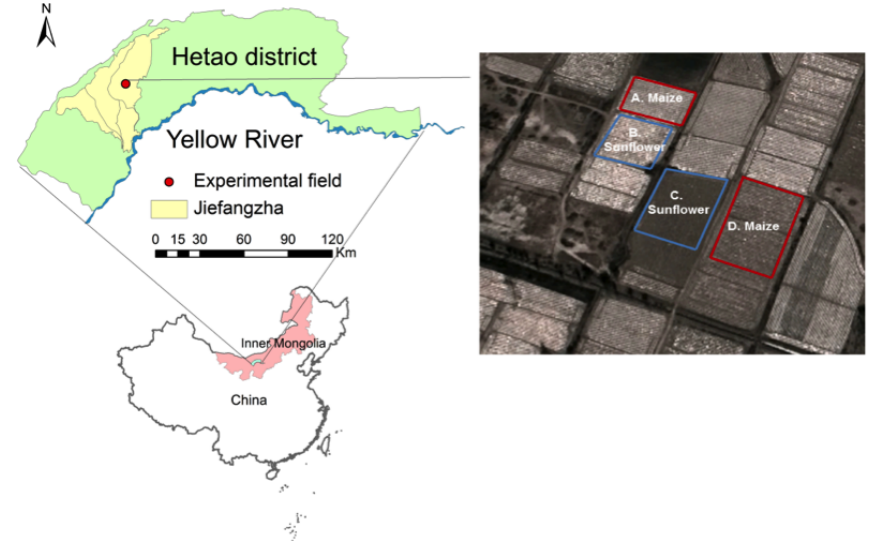
Figure 3. Location of the Shahaoqu experimental field. (Note: the figure was downloaded from © Google Earth. The imagery was taken on 8 April